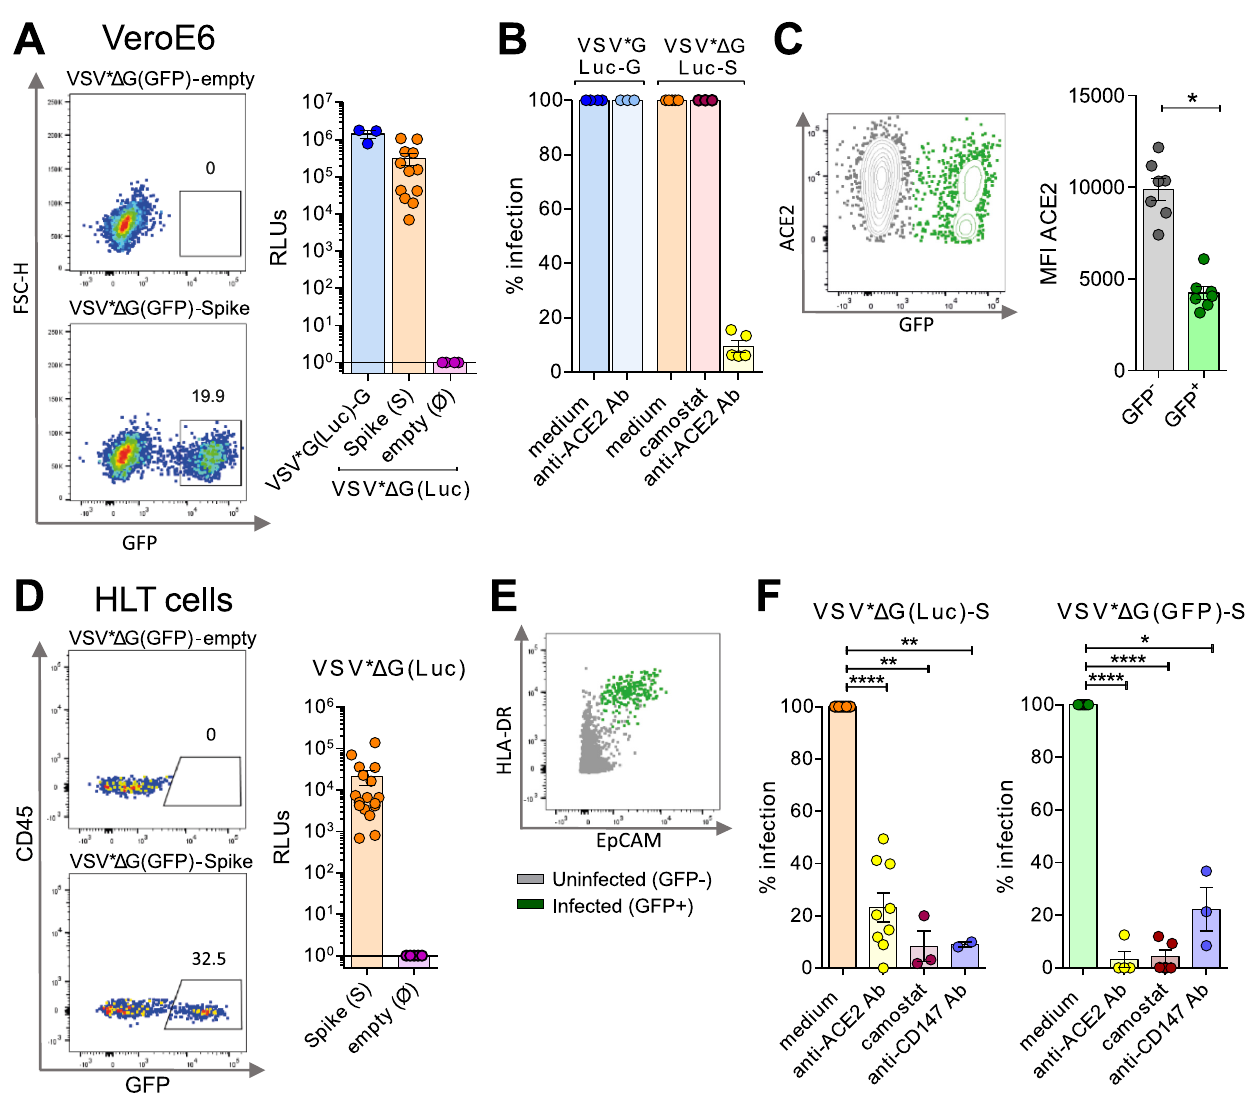
Fig 2. Susceptibility of VeroE6 and the HLT model to SARS-CoV-2 viral entry. VeroE6 and HLT cells were infected with two different viral constructs (GFP and Luciferase) expressing the spike protein upon viral entry; VSV � Δ G(GFP)-Spike and VSV � Δ G(Luc)-Spike. ( A ) Representative flow cytometry plots of VeroE6 cells infected with VSV � Δ G(GFP)-Spike or the background form VSV � Δ G(GFP)-empty (left panel); and luciferase activity (RLUs; relative light units) at 20h post-infection with the pseudotyped VSV � G(Luc)-G, the VSV � Δ G(Luc)-Spike or the background form VSV � Δ G(Luc)-empty (right panel). ( B ) Percentage of viral entry after treatment with anti-ACE2 antibody (10 μ g/ml) and camostat (100 μ M) in VeroE6 cells infected with the pseudotyped virus expressing the control G protein or the spike from SARS-CoV-2. ( C ) A flow cytometry plot showing ACE2 expression in GFP + VeroE6 cells. Right graph shows mean fluorescence intensity (MFI) of ACE2 in both infected and uninfected fractions, based on GFP expression. ( D ) Representative flow cytometry plots of HLT cells infected with the viral construct expressing the spike protein (VSV � Δ G(GFP)-Spike) or the background form (VSV � Δ G(GFP)-empty) (left panel); and luciferase activity (RLUs; relative light units) at 20h post-infection with the VSV � Δ G(Luc)-Spike or the background form VSV � Δ G(Luc)-empty (right panel). Infection was measured as the percentage of GFP or RLUs, respectively. ( E ) Susceptible HLT cells to viral entry (identified as GFP + cells) compatible with an AT-II phenotype, determined by the co-expression of HLA-DR and EpCAM in the CD45 - CD31 - fraction of live cells. ( F ) Bar plots showing the percentage of viral entry inhibition on HLT cells in the presence of anti-ACE2 antibody (15 μ g/ml), camostat (100 μ M) or anti-CD147 antibody (25 μ g/ml) after cell challenge with VSV � Δ G(Luc)-Spike (left graph) or VSV � Δ G(GFP)-Spike (right graph). Mean ± SEM is shown for all graphs. Data in panel 2C were analyzed by a Wilcoxon matched-pairs test; � p < 0,05. Data in panel 2F were analyzed by one sample t-test; � p < 0.05, �� p < 0.01, �� p < 0.0001.